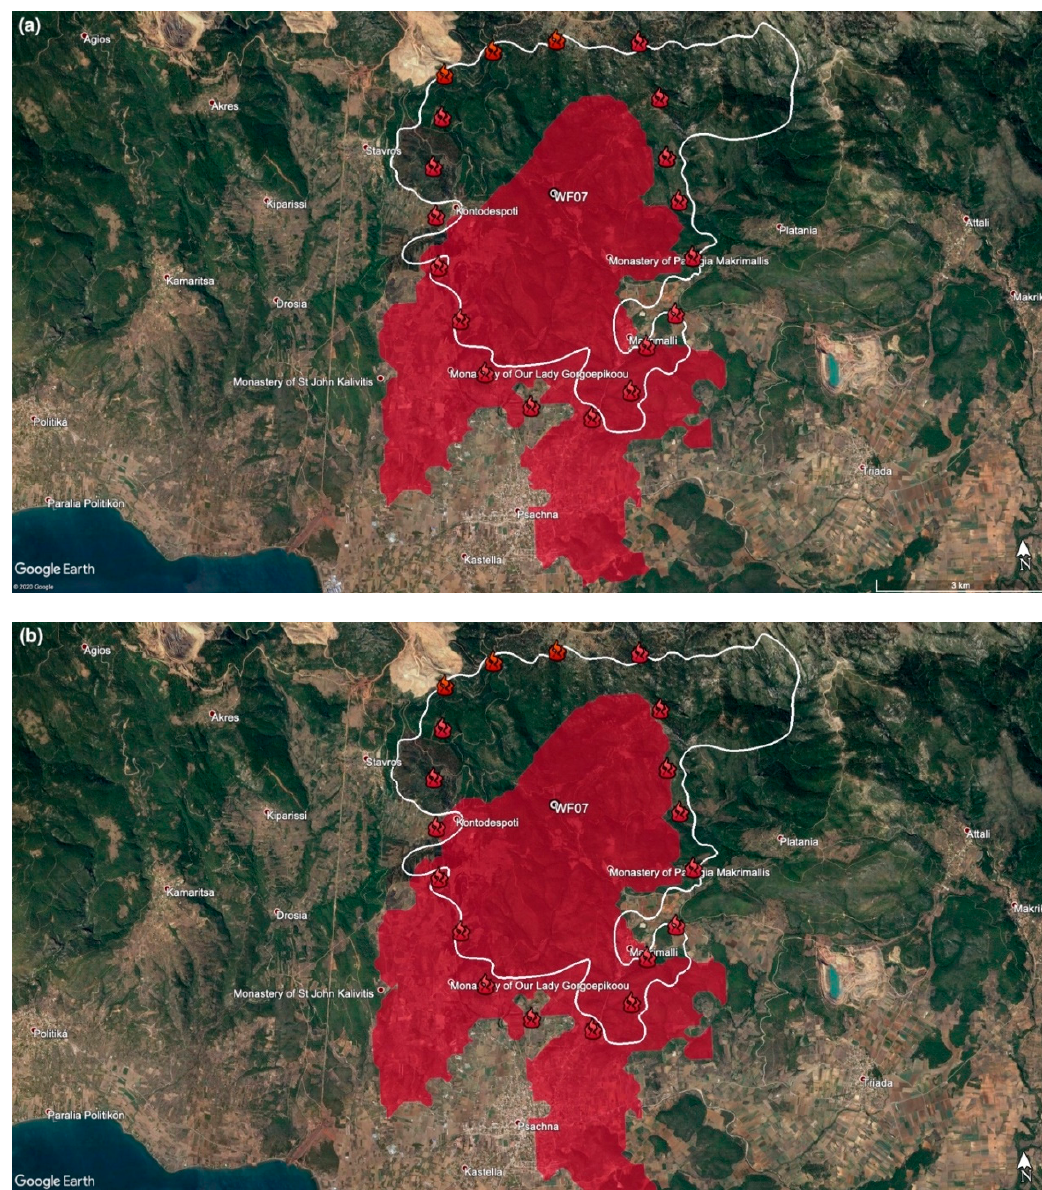
Figure 5. Visual comparison between the approximate location of the wildfire’s fronts (red flames) and IRIS’s prediction at 19:00 UTC on 13 August. The black dot (WF07) denotes the provided ignition location. White contours denote the actual final wildfire perimeter. ( a ) Operational wildfire spread prediction based on IRIS’s activation time, and ( b ) Retrospective wildfire spread prediction based on actual ignition time.